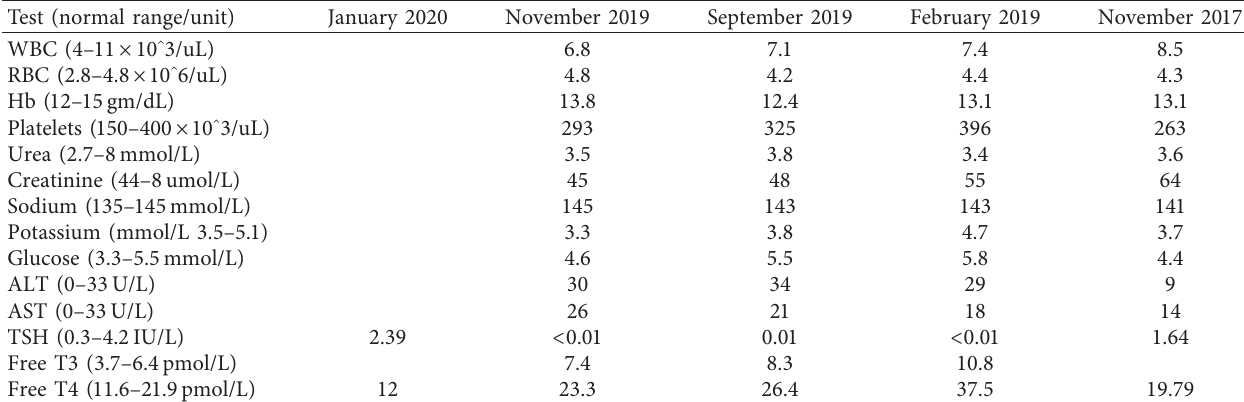
Table 1: The patient’s laboratory test